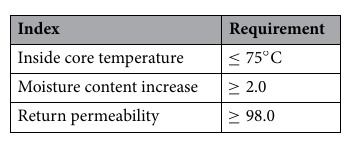
Table 1. Vacuum regain moisture index and requirement.